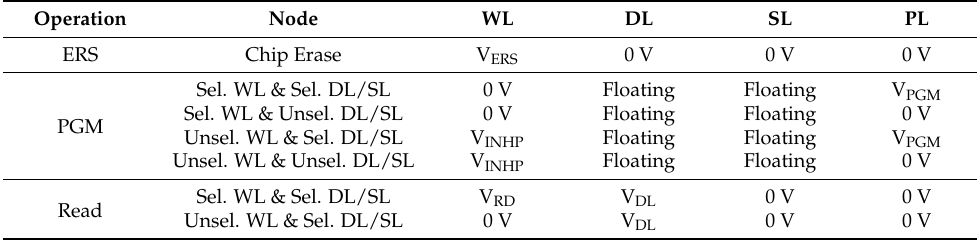
Table 1. Bias conditions of TFT eFlash cell for each operation mode.